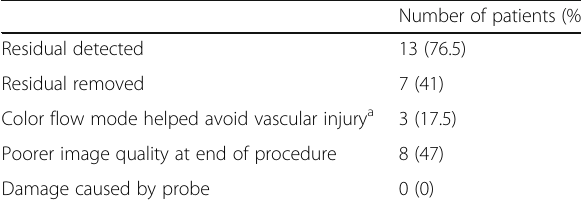
Table 6 Intraoperative ultrasound added value